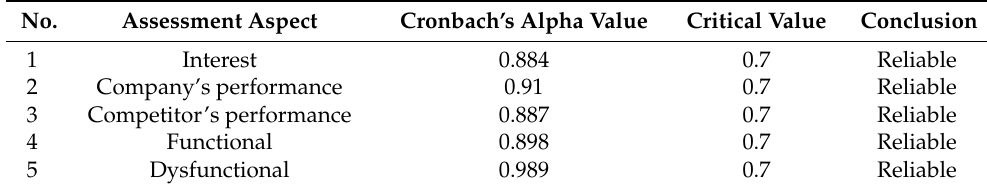
Table 5. Initial Questionnaire Reliability Test Results SIPA